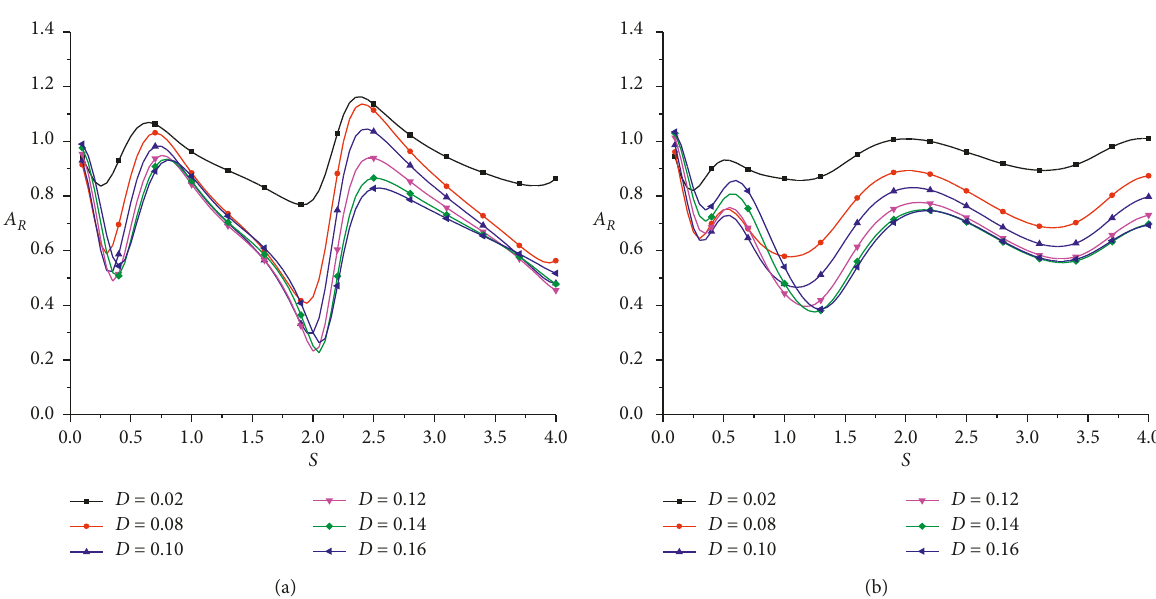
Figure 8: Variation curve of A R of ground displacement with distance for various Duxseal thicknesses: (a) radial displacement and (b) vertical displacement.